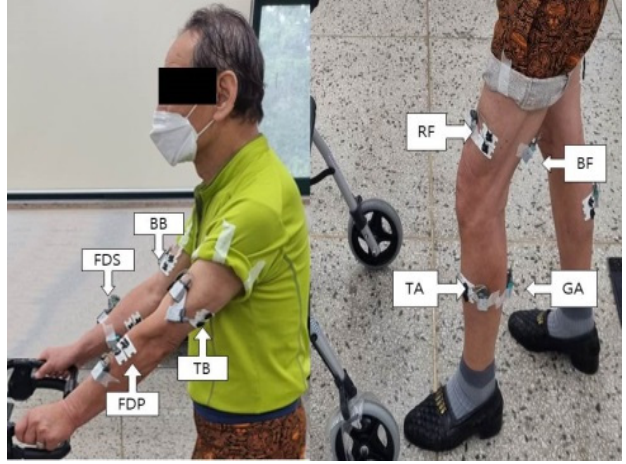
Figure 7. Electrode positioning for the measurement of upper and lower extremity muscle activity.